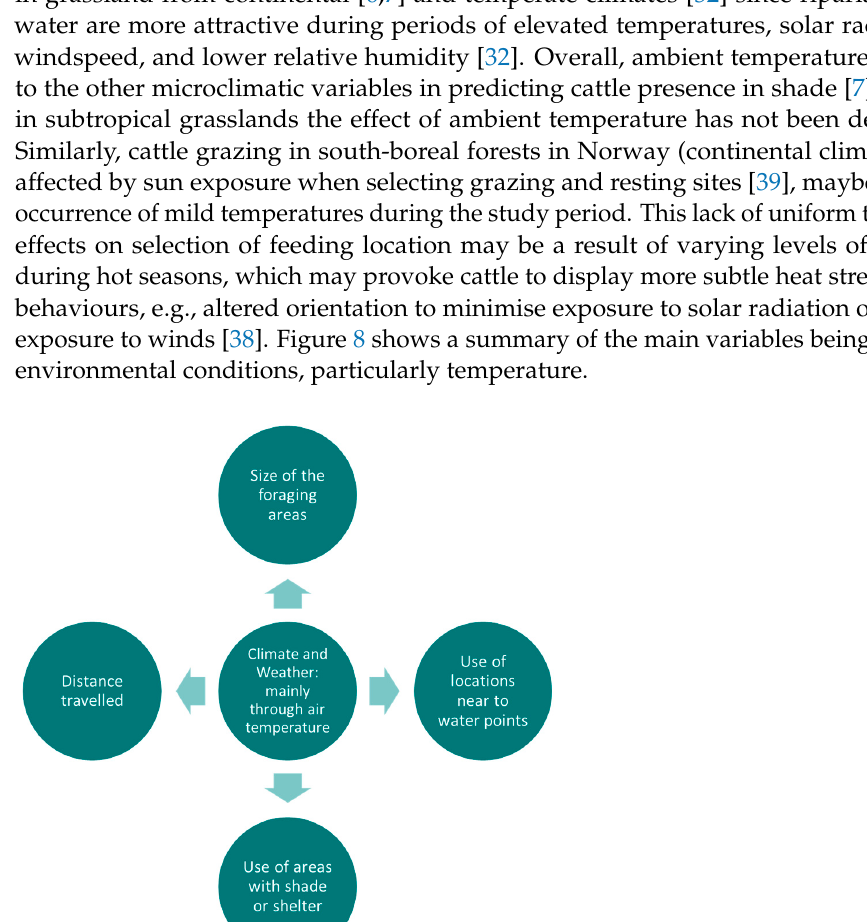
Figure 7. Summary diagram of the main variables of site use preference being affected by the loca- tion of water points.